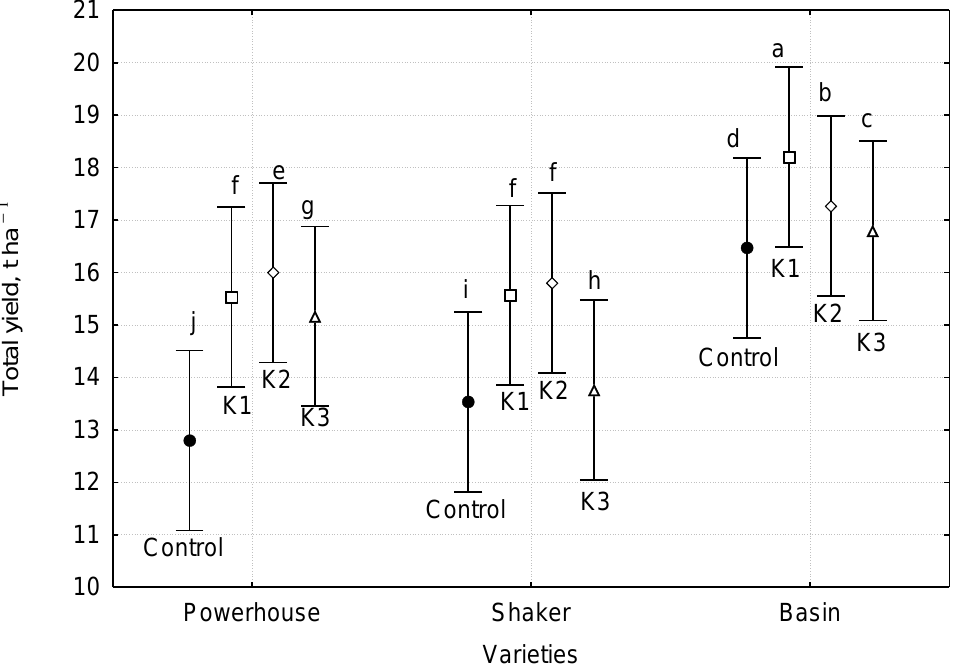
Figure 2. Changes of mean corn cobs yield values with 95% confidence intervals relative to the number of light exposures and respective maize cultivars (mean of two years). Means with the same letter are not significantly different from each other ( p < 0.05—ANOVA followed by Tukey test). Error lines represent ± standard deviation of the mean.